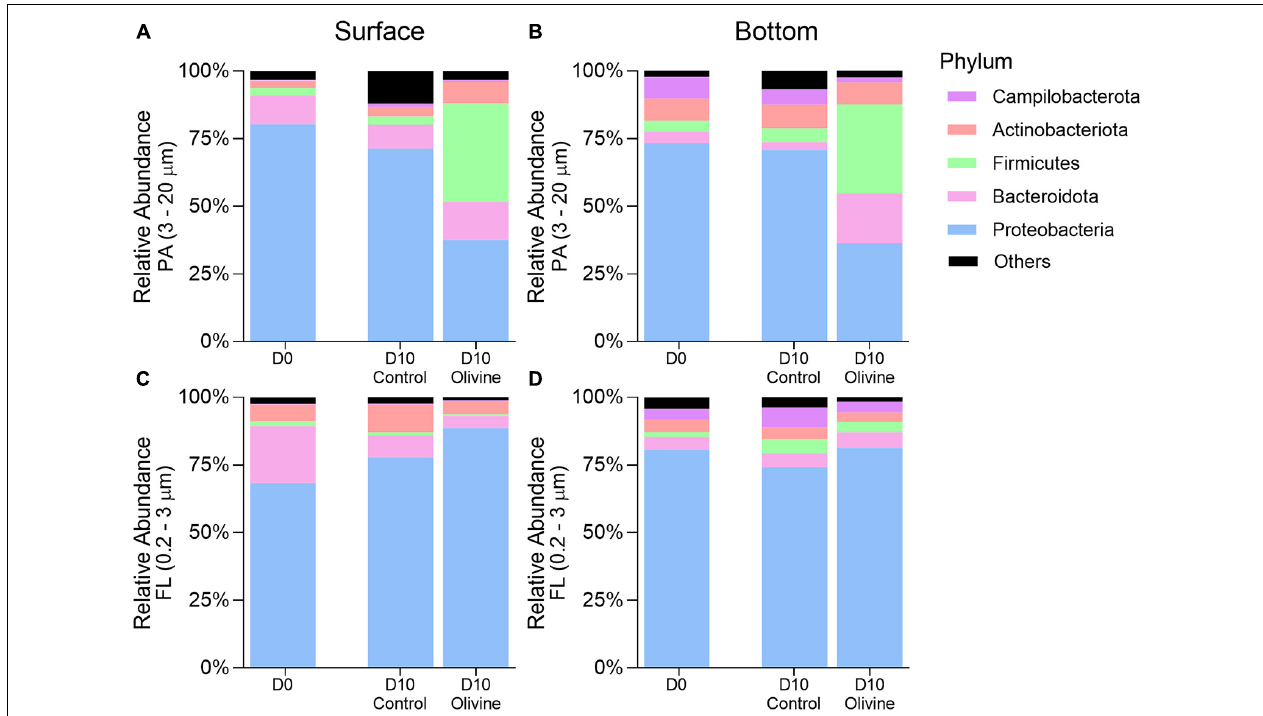
FIGURE 4 | Changes of averaged relative abundance ( N = 3) of particle-attached (A,B) PA, 3–20 µ m and free-living (C,D) FL, 0.2–3 µ m bacterial communities at the phylum level in initial and 10-day incubated seawater with or without olivine addition, from the surface (A,C) and bottom layers (B,D) of the sampling site. The standard deviations of bacterial relative abundances are shown in Supplementary Figure 2